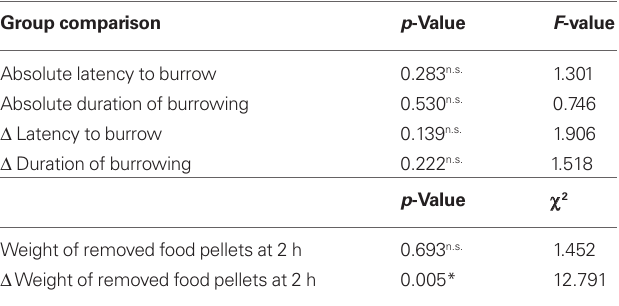
Table 3 | results of ANOVA for experimental absolute and ∆ latencies to burrow and durations of burrowing and of Kruskall–Wallis test for experimental absolute and ∆ weights of removed food pellets for all four groups.